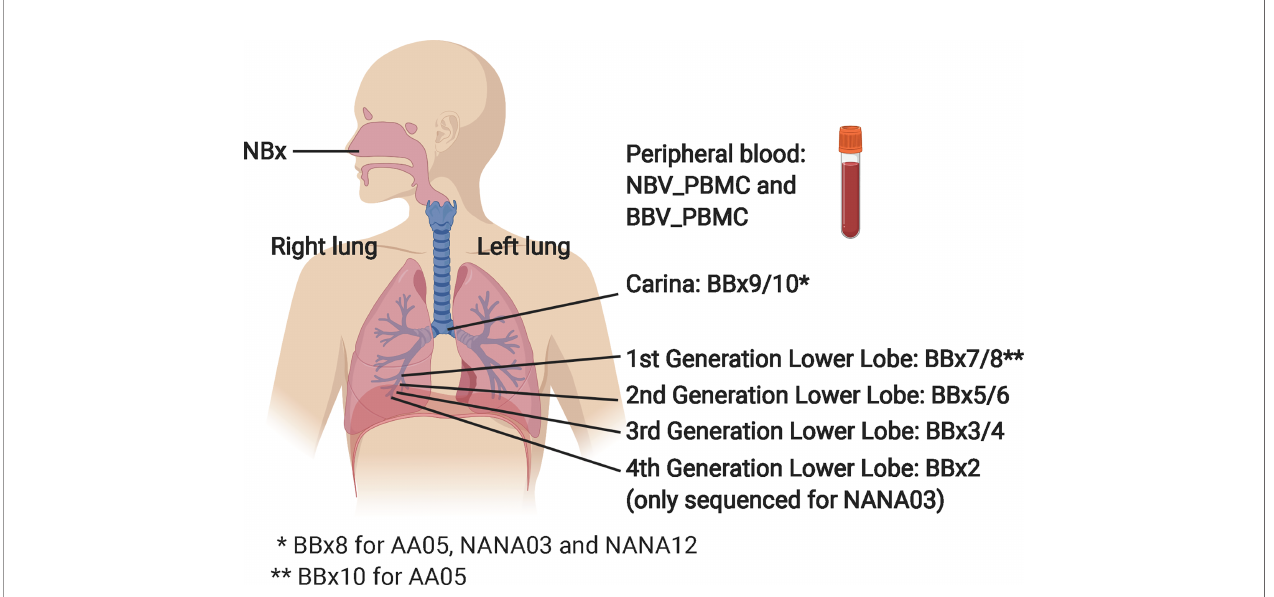
FIGURE 1 | Schematic showing origins of the various samples from the nasal mucosa, the right lung bronchial mucosa and the peripheral blood. The NBV_PBMC and BBC_PBMC peripheral blood sample were collected at the same time as the nasal biopsy (NBx) and the bronchial biopsies (BBx), respectively. For AA07, three biopsies from the left lung were also collected: BBx11 (3 rd generation lower lobe), BBx12 (2 nd generation lower lobe) and BBx13 (1 st generation lower lobe). The carina is at the bottom of the trachea where it divides into the left and right main bronchi. 4 th generation lower lobe biopsies were collected from all subjects but only sequenced from NANA03 as this individual lacked a 1 st generation lower lobe biopsy sample. This fi gure was created in